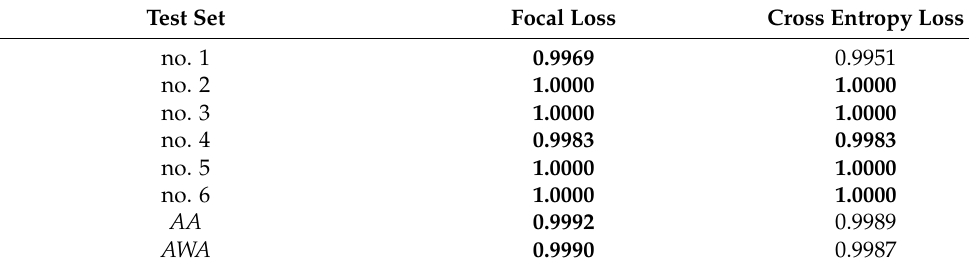
Table 8. Test results of models trained using different loss